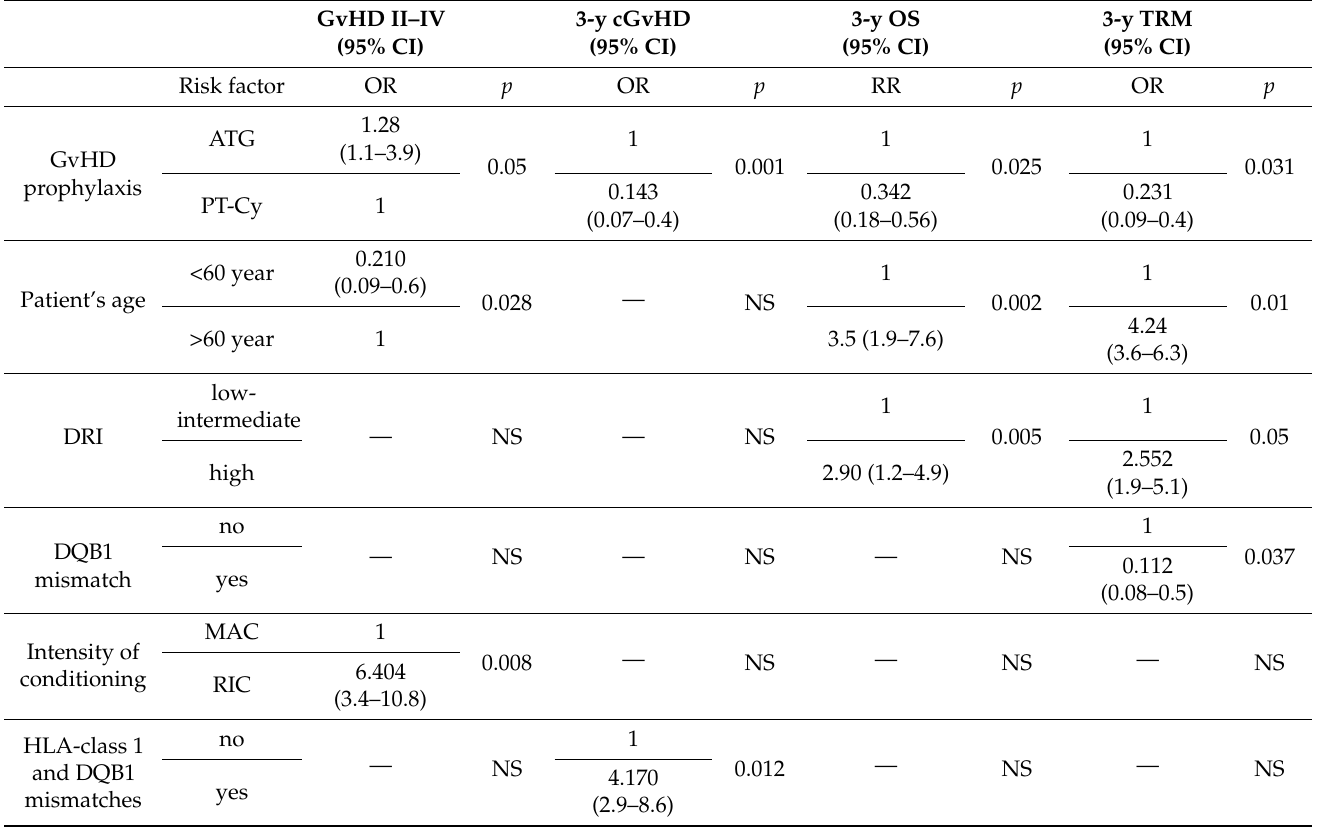
Table 3. Multivariate analysis of factors significantly associated with HSCT outcome. OS = overall sur- vival, TRM = transplant-related mortality, OR = odds ratio, RR= relative risk, ATG = anti-thymocyte globulin, PT-Cy = post-transplant cyclophosphamide, DRI = disease risk index, MAC = myeloablative conditioning, RIC = reduced intensity conditioning, MM = mismatch. The lines in the boxes indicated an absent result. PT-Cy prophylaxis showed a significant value for the GvHD II–IV group in patients more than 60 years old. The RIC conditioning also influenced the GvHD II–IV. The 3-y cGvHD was influenced by PT-Cy and by double MM class 1 and DQB1. The 3-y OS and TRM were influenced by PT-Cy, the patient’s age and also by a high